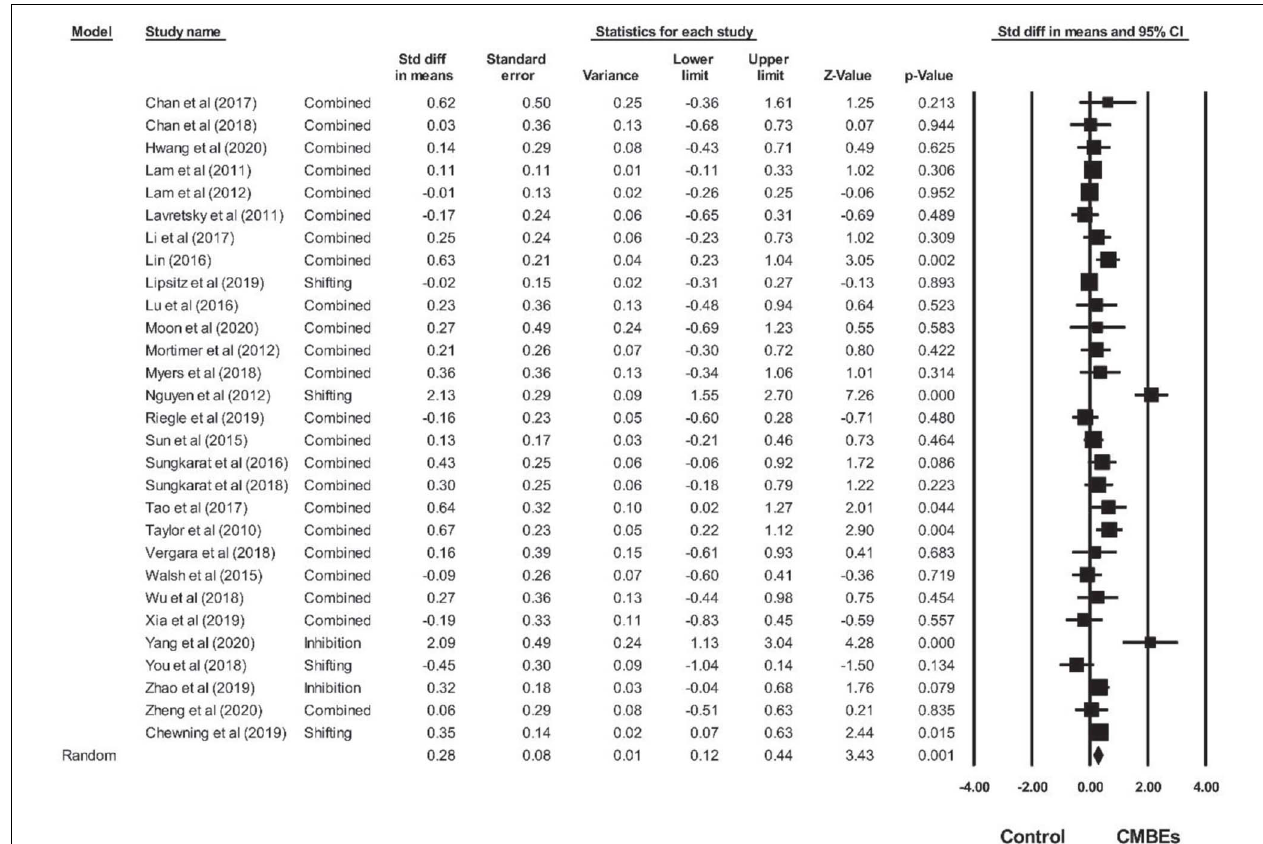
FIGURE 2 | Forest plot of Chinese mind-body exercises on overall EF.